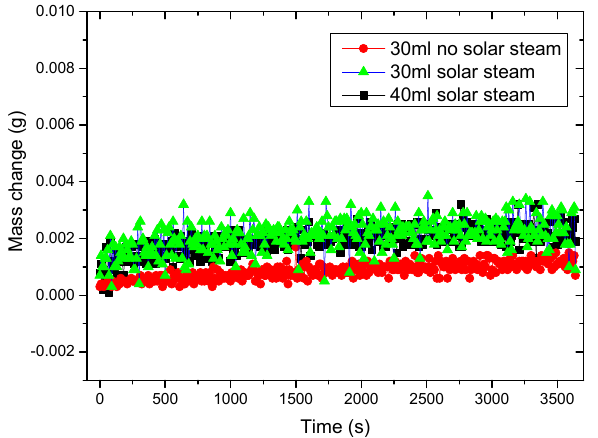
Figure 9. Evaporation rates of water with and without the solar steam structure material.